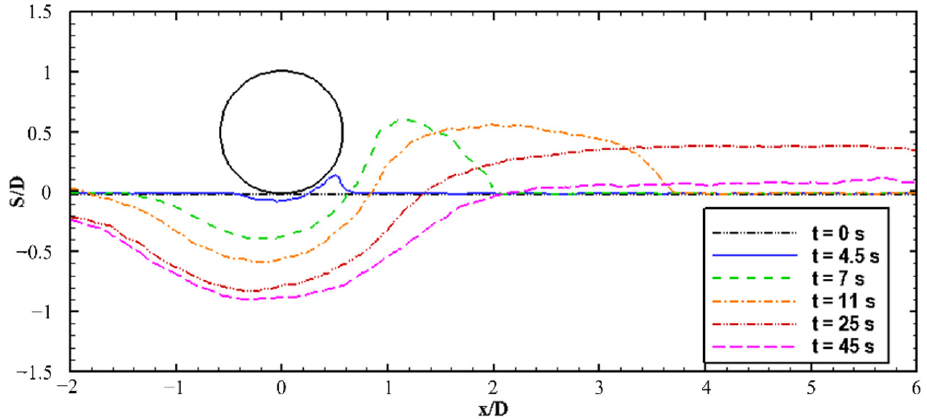
Figure 11. Evolution of bed profile.